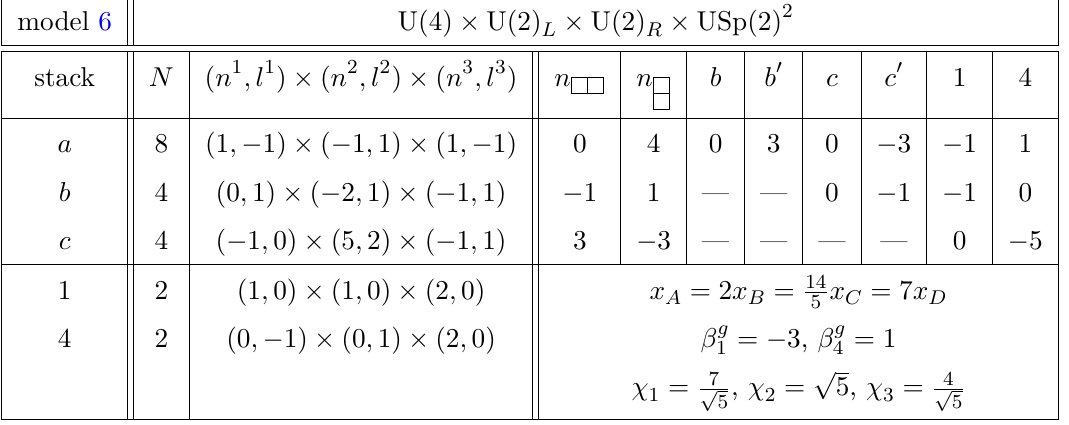
Table 6 . D6-brane configurations and intersection numbers of Model 6, and its MSSM